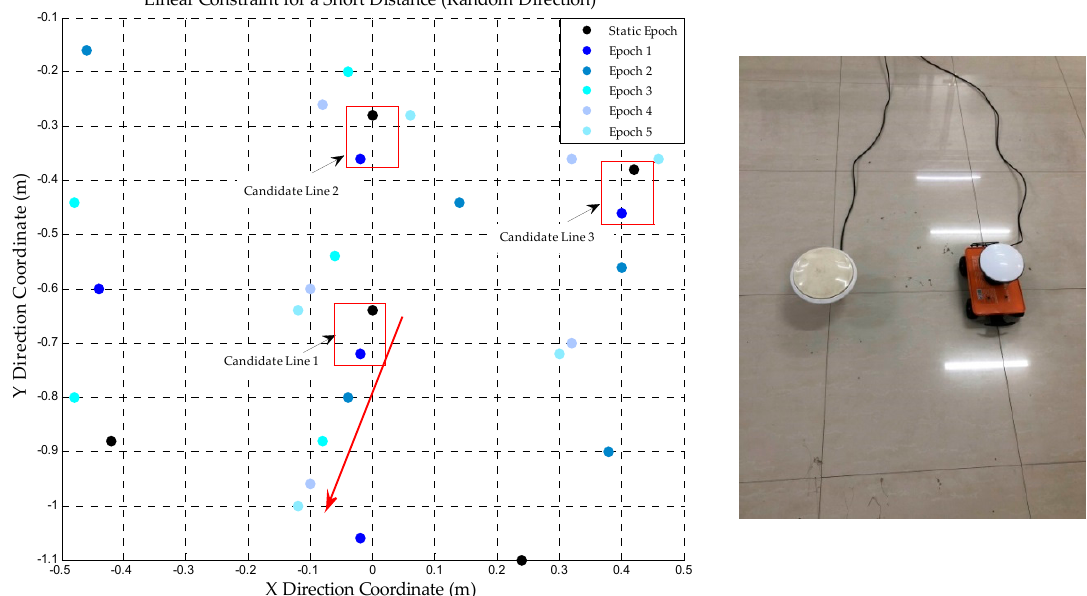
Figure 10. The trajectory obtained by AFM during the linear constraint (random direction), the right image shows the dolly for linear constraint test